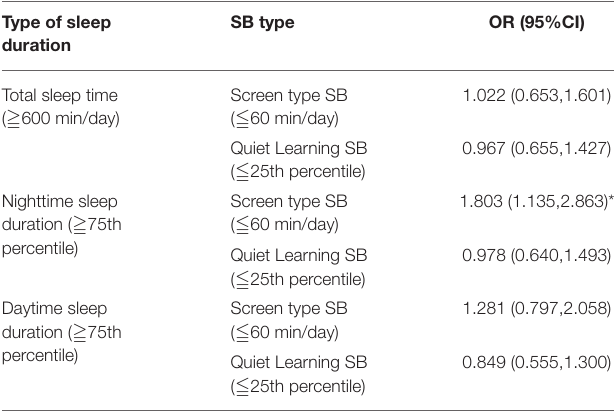
TABLE 6 | Protective and risk factors of adequate sleep for children of different sedentary